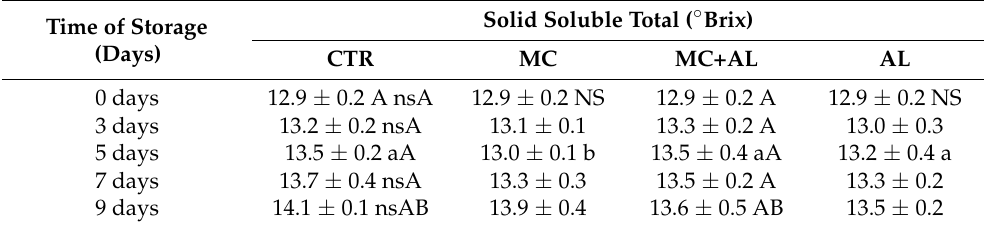
Table 1. Solid soluble total of fruit slices of Actinidia deliciosa (Liang. Ferguson) coated with O. ficus-indica (OFI) mucilage (MC), or mucilage + A. arborescens (MC+AL) or A. arborescens (AL) not treated (CTR), just after being coated (0) and at 3, 5, 7, 9 d of storage at 5 ◦ C. Different lowercase letters indicate significant differences between treatments at each sampling date. Different capital letters indicate significant differences between sampling date for the same treatment. Tukeys’ significant test was applied at p ≤ 0.05. Data are means ± S.E. ( n = 3). Time of Storage (Days)